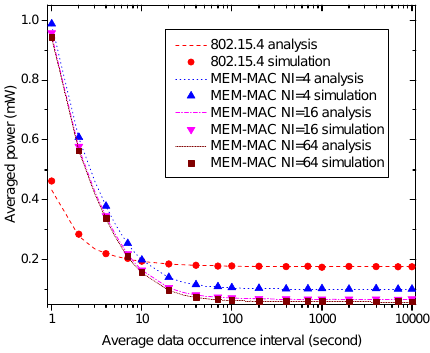
Figure 11. How the node average power changes with the average data occurrence interval.